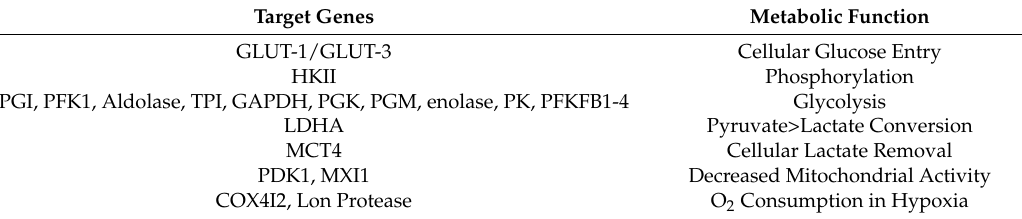
Table 1. Targets of HIF-1 α . Adapted from Denko et al.